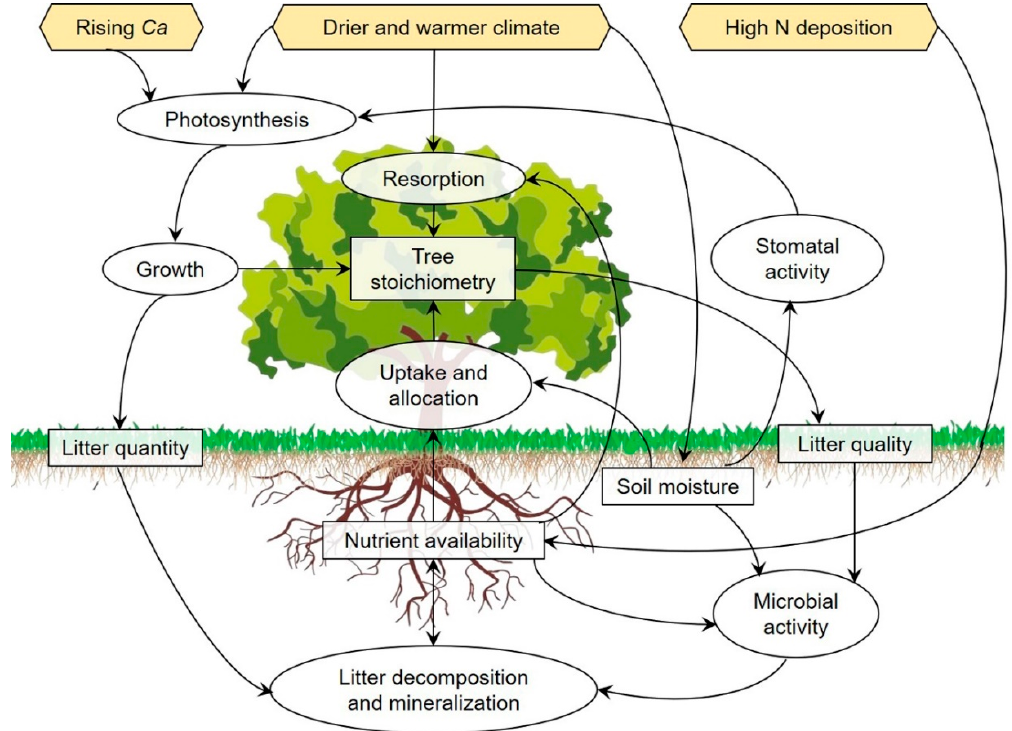
Figure 4. Conceptual diagram of the impacts of global change on processes controlling stoichiometry of trees. Yellow hexagons are global change drivers: increasing atmospheric CO 2 concentration (Rising Ca ); climate change leading to drier and warmer conditions and high rates of atmospheric nitrogen (N) deposition; rectangles represent nutrient pools; and ellipses indicate biogeochemical processes.